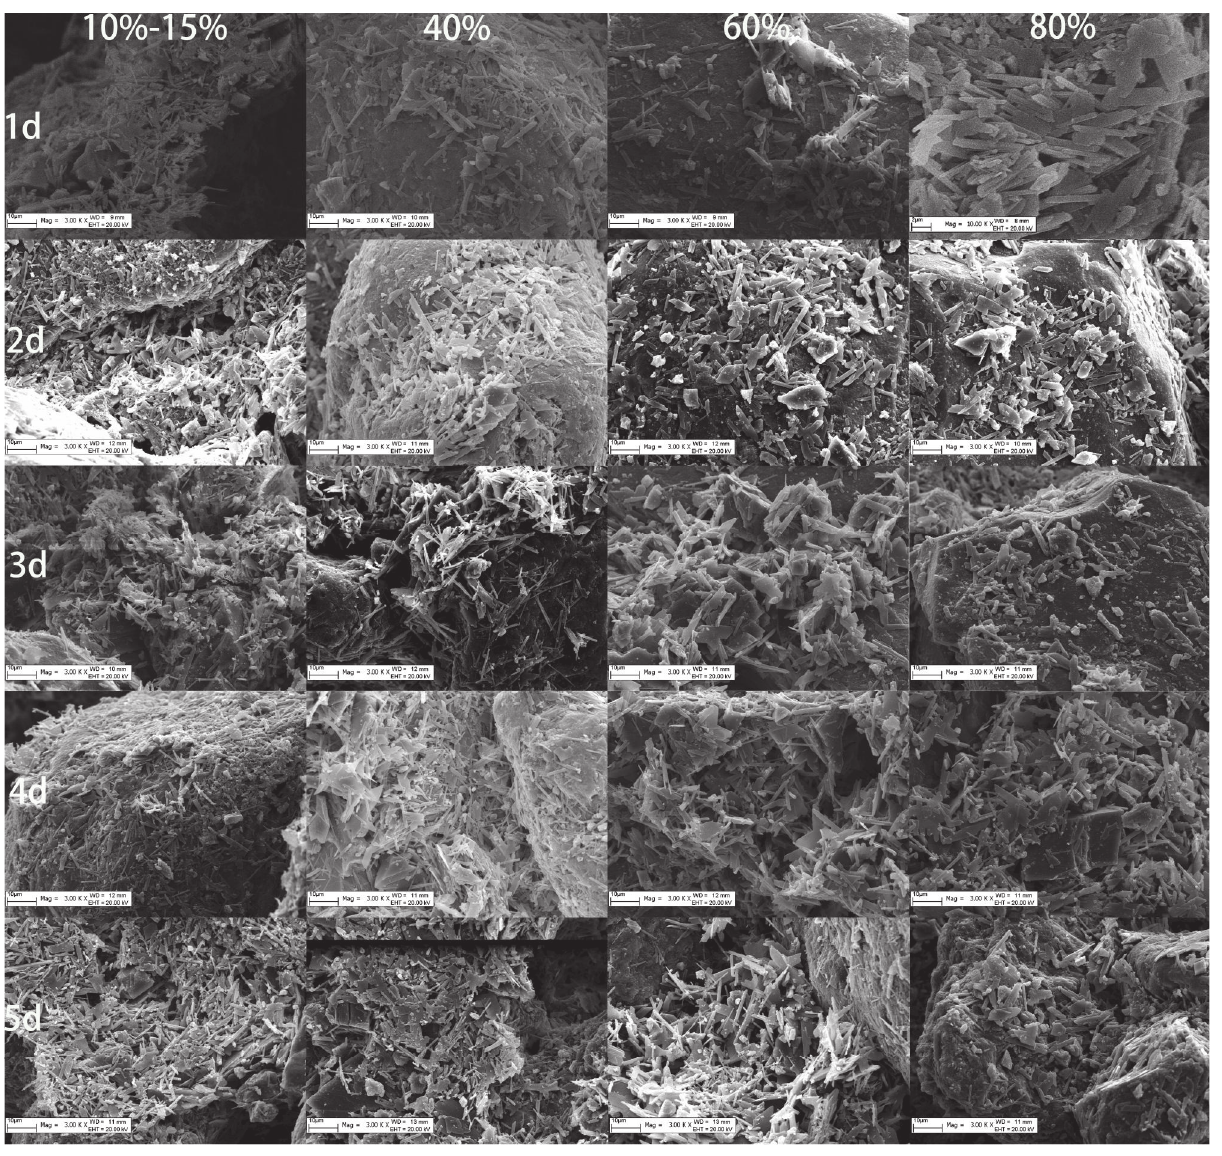
Figure 7: Microstructure characterization and development features of the gypsum-cemented similar